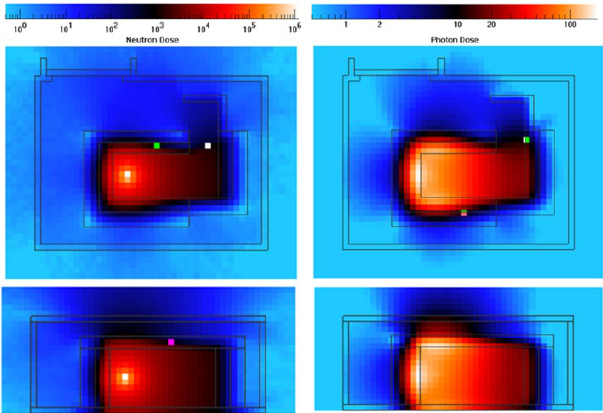
Fig. 7. Calculated dose rate distribution resulting from neutron and photon radiation when the DT generator is operated at its maximum yield (10 8 n/s), with Layer 1 and 2 being composed of borated